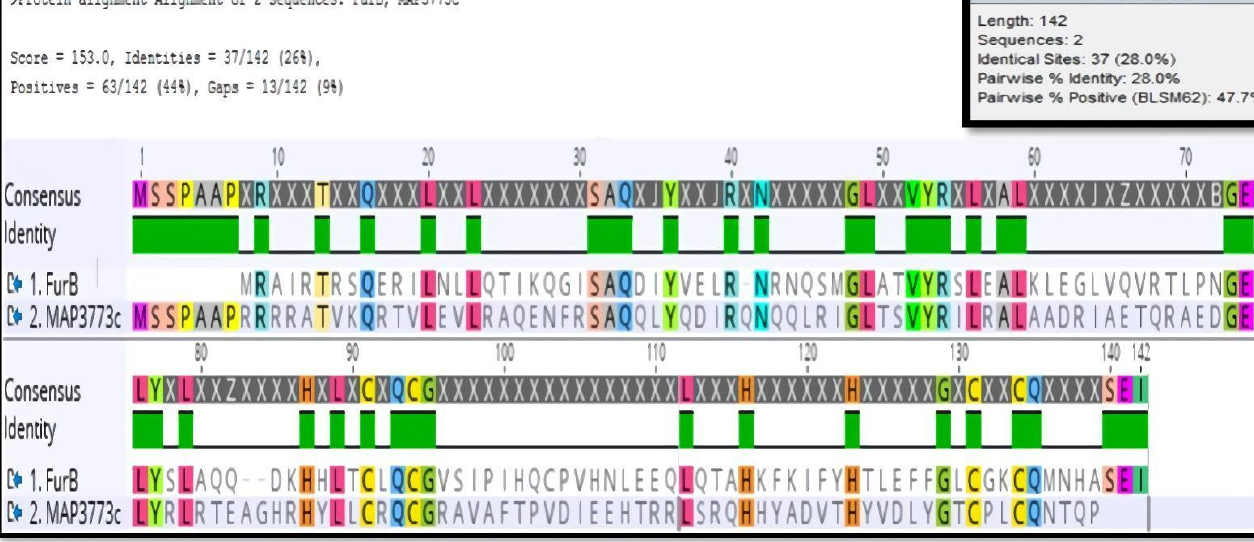
Figure 9. Bioinformatic alignment of the amino acid sequences of the MAP3773c protein of MAP and FurB of Anabaena sp. PCC7120. WP_010996629.